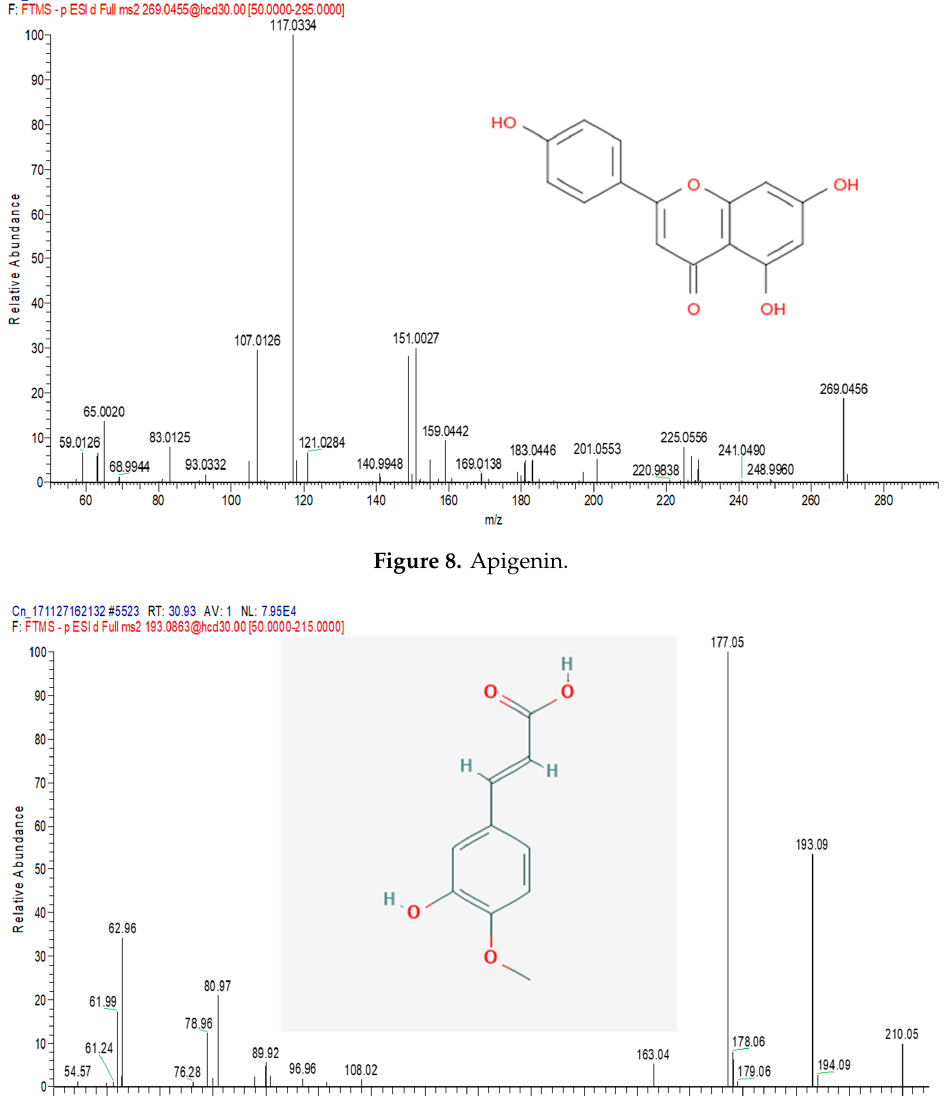
Figure 9. Ferulic acid.